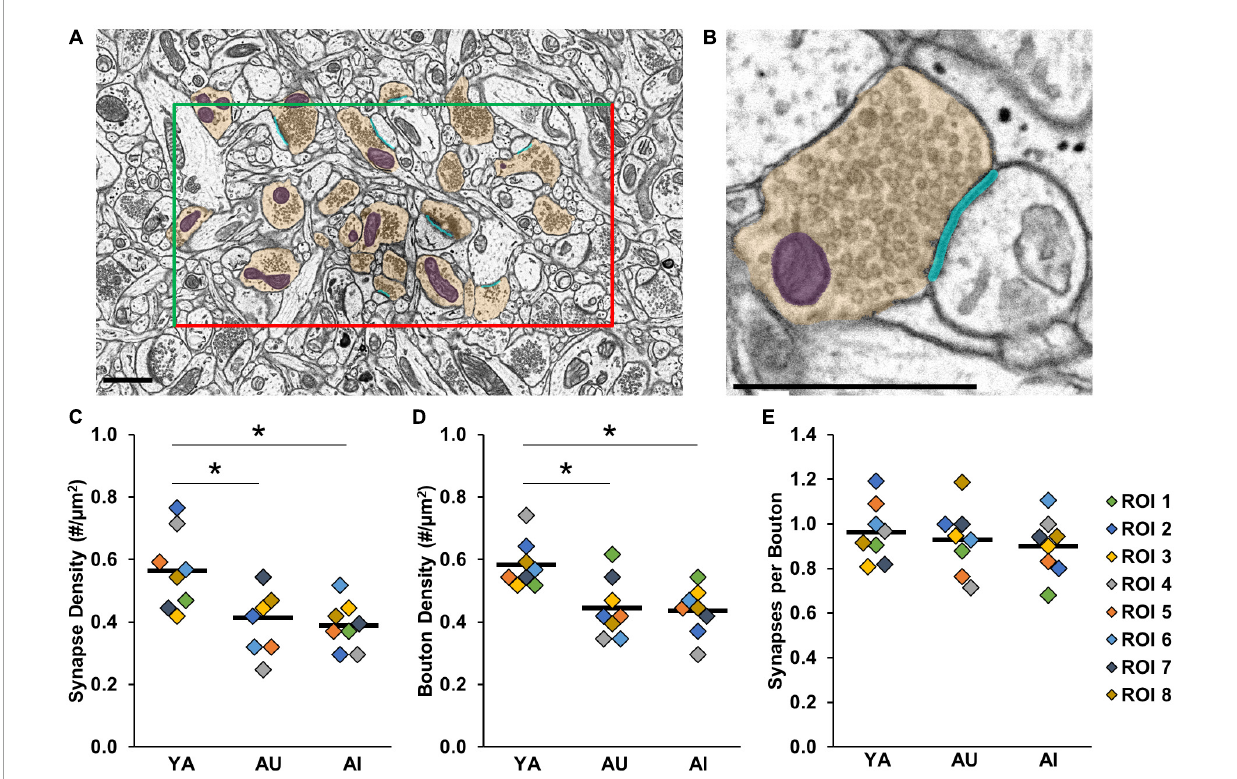
FIGURE2 Synapse and bouton density are decreased in aged marmosets compared to young, regardless of working memory capacity. (A) Reference section with one region of interest (ROI) outlined by two inclusion (green) and two exclusion (red) lines. Included presynaptic boutons are segmented in yellow, synapses in cyan, mitochondria in purple. Scale bar = 1 µ m. (B) Zoomed in view of one synaptic complex. Colors and scale bar as in panel (A) . (C) Synapse density (D) Bouton density (E) Synapses per bouton. There were an equivalent number of synapses per bouton across animals. In panels (C–E) , colored diamonds represent measures taken in each of the ROIs. Horizontal black bars represent average across the ROIs. * p <